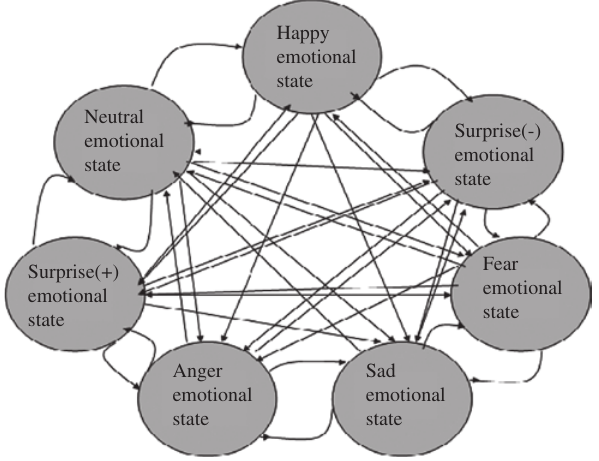
Figure 5. State Diagram for Emotion